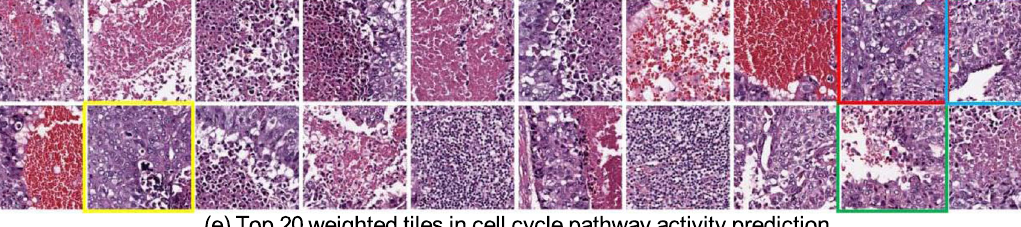
Fig. 4 Weight maps of tiles when predicting the point mutation status of RB1 and cell cycle pathway activity from mRNA expression data in breast cancer. a Tumor tiles after data processing. b Weight map of tumor tiles in RB1 point mutation prediction. Brighter green tiles have larger weights. c Weight map of the cell cycle pathway activity prediction. d, e Top 20 weighted tiles for the RB1 point mutation prediction and cell cycle pathway prediction, respectively. We marked four tiles that appear in both tasks. These tissues contain poorly differentiated breast carcinoma with necrosis or hemorrhage from a pathologist ’ s perspective. Table 5. AUC (with 95% CI) achieved by the models trained on the pathway activity derived from mRNA expression data of breast cancer. Pathway p53